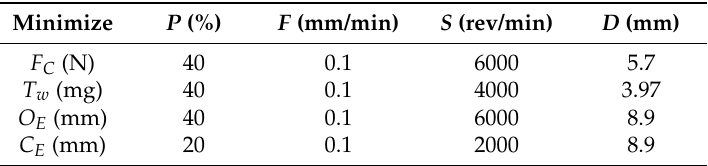
Figure 8. Effect of tool diameter on the performance parameters. ( a ) On Cutting Force ( F C ); ( b ) On Tool Wear ( T W ); ( c ) On Over Cut Error ( O E ); ( d ) On Cylindricity Error ( C E ). Table 5. Optimal machining conditions.